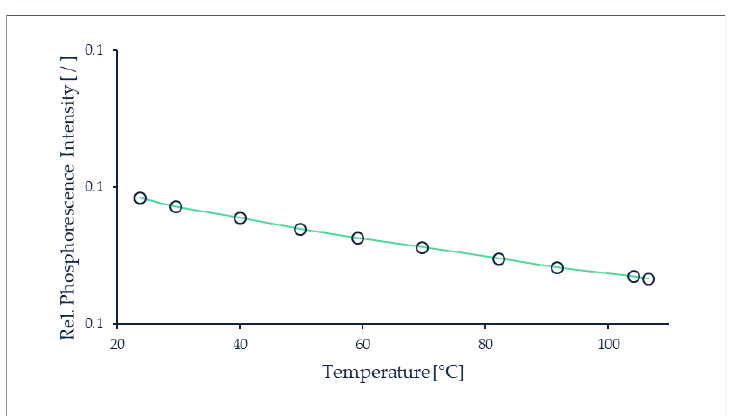
Figure 35. Temperature dependence of diacetyl phosphorescence, measured by Jian-Bang et al. [182]. The data are relative to initial phosphorescence, obtained from measurements at t = 20 µ s (1% of the phosphorescence lifetime) and extrapolated at t = 0. Data from